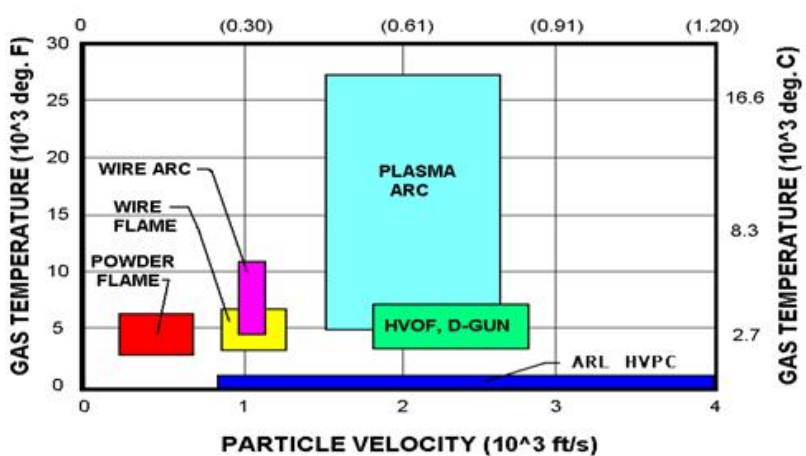
Figure 3: Comparison between different thermal spraying